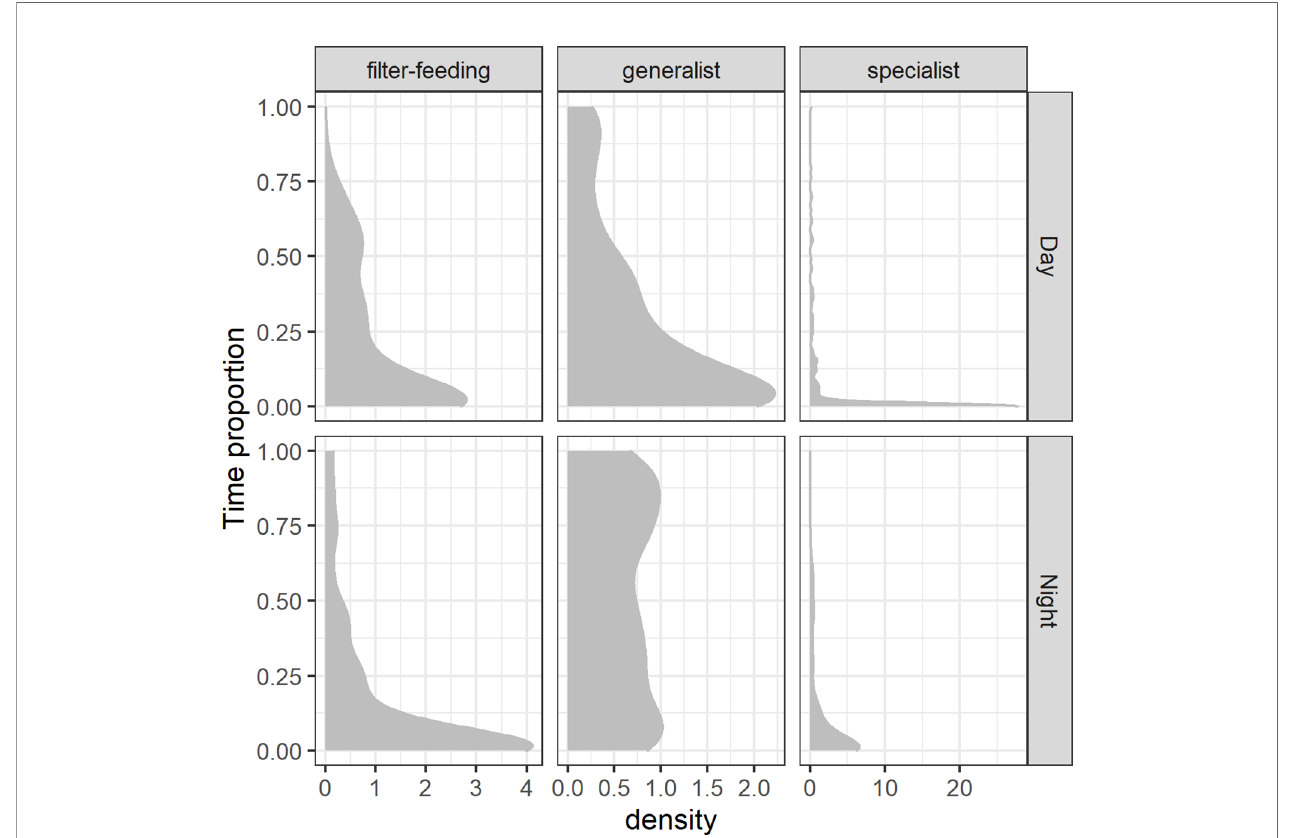
FIGURE 7 | Density plot of the smooth distribution of the proportion of time spent in surface waters ( ≤ 10 m in depth; T10 ) by pelagic elasmobranchs grouped by their feeding habits ( fi lter-feeding, generalist, specialist) and across the diel cycle (night and day).